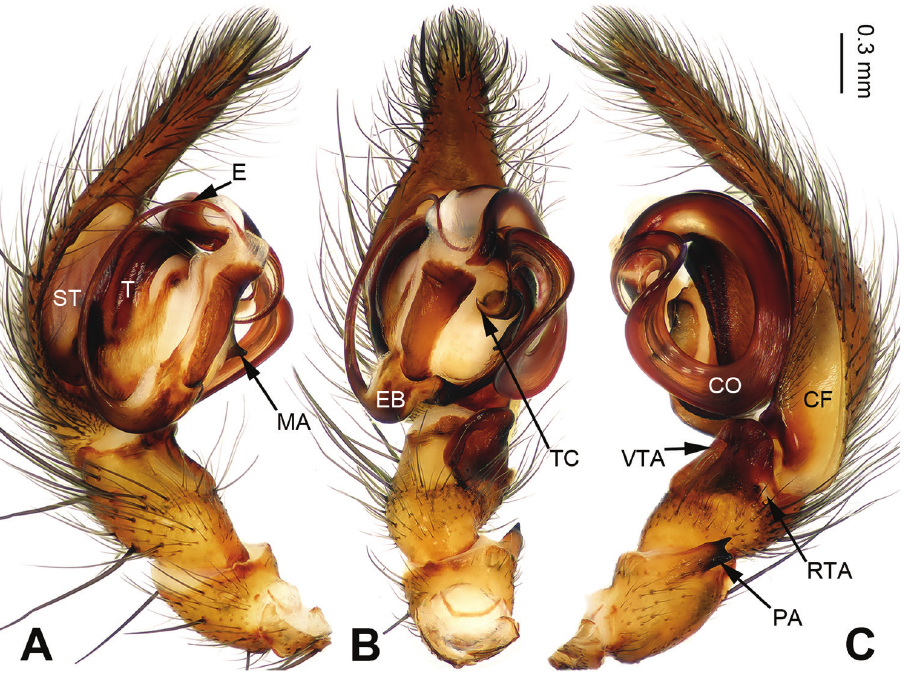
Figure 3. Palp of Pireneitega liansui , specimen from Diaoxian. A Prolateral view B Ventral view C Ret- rolateral view. Scale bar: equal for A, B, C